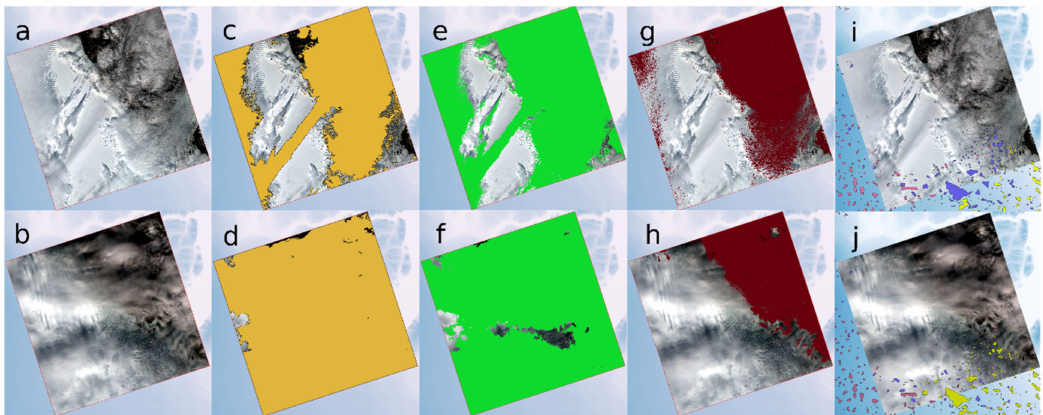
Figure 8. Comparison example of cloud masking procedures for 3 July 2017 ( a , c , e , g , i ) and 7 July 2017 ( b , d , f , h , j ): a , b : true-color image (band combination 4–3–2) of granule 26XNP; c , d : native level 1C cloud mask; e , f : fmask with default configuration; g , h : level 2A cloud mask (20 m resolution); i , j : results from the cloud classification matrix applied to the sink mask over the same granule. Labeled in pink are sinks where no lake was detected, purple are sinks where initially water was detected but was labeled as cloud/cloud covered, and yellow are sinks where lakes were detected and not labeled as